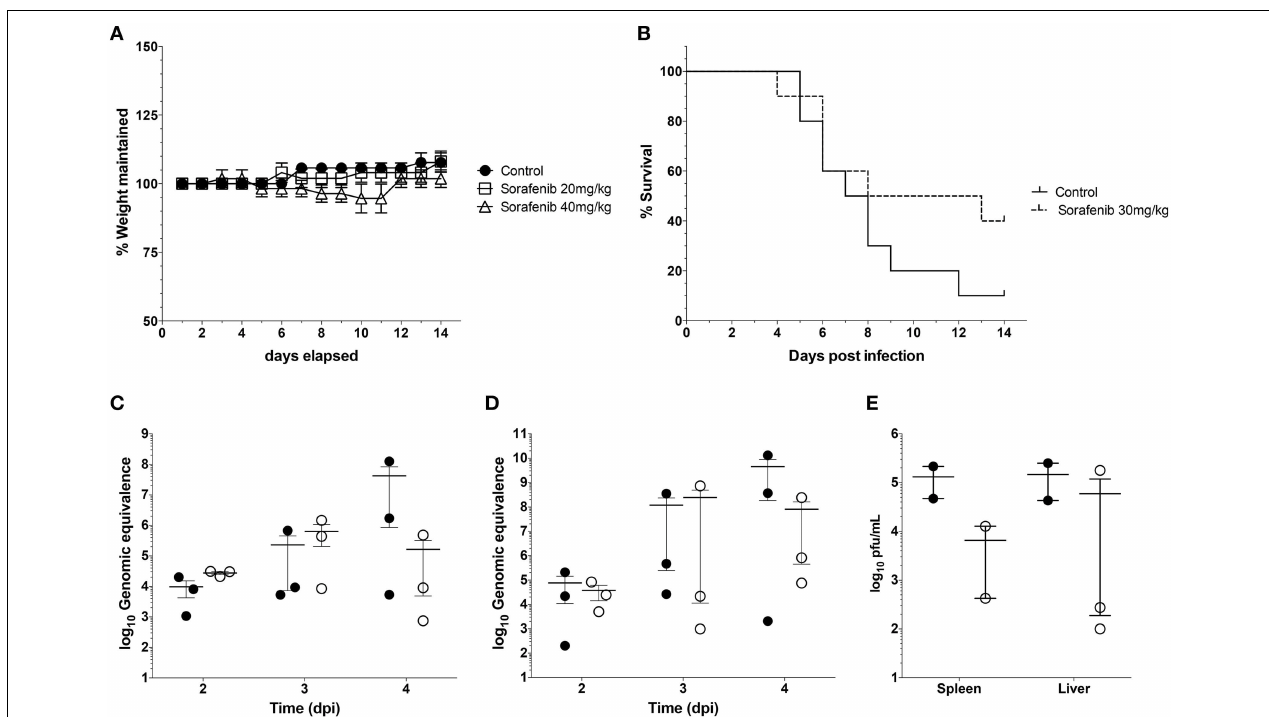
control via oral gavage. Animals were monitored for 14 days post challenge and survival curves determined. Data plotted represents 10 animals per treatment group. (C) thru (E) Mice infected and treated as described above were sacrificed at 2, 3, and 4 days post infection (dpi). Livers and spleens were harvested. RVFV genomic copies within the spleen (C) or liver (D) were quantified by qRT-PCR for each day. Infectious viral titers (E) were determined for day 4 only by plaque assay. Data plotted represents means and standard deviations from three animals per condition. Filled in circles and open circles represent sorafenib and solvent controls